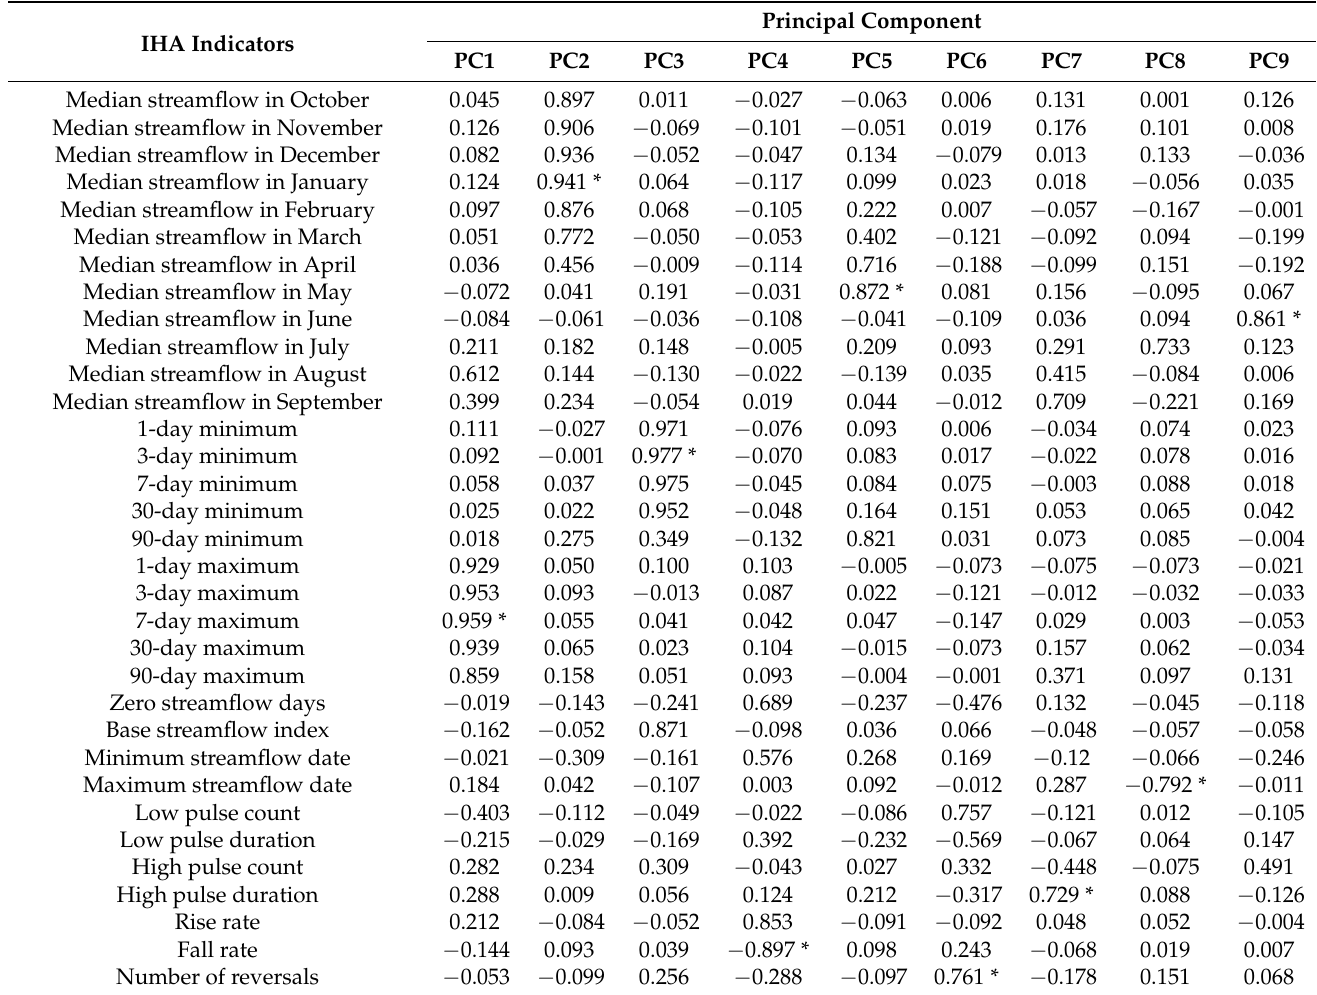
Table 5. Load value of each indicator of PC1 to